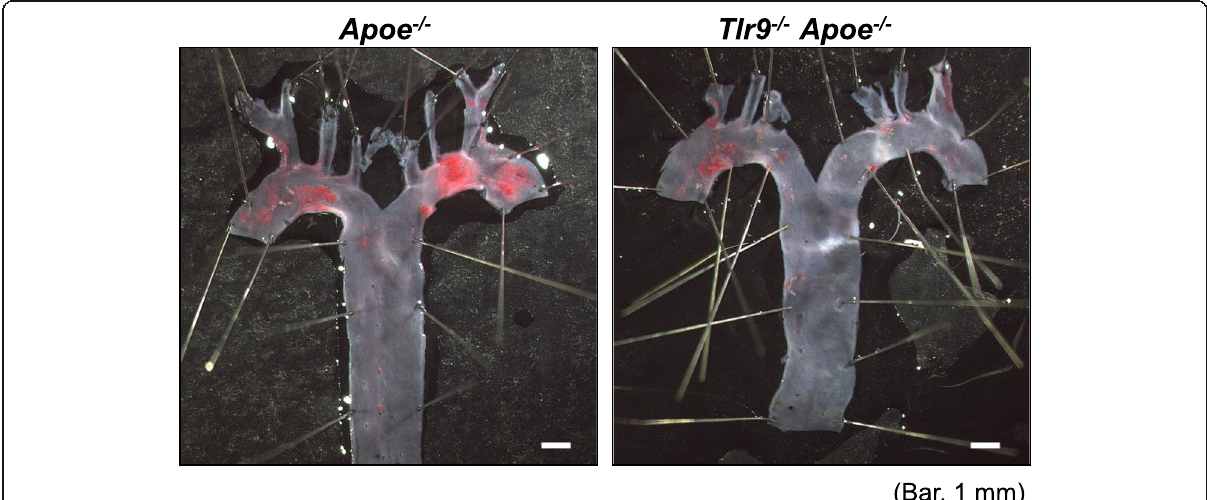
Fig. 4 Genetic deletion of TLR9 attenuated the development of atherosclerosis. Representative figures of Sudan IV staining of the aortic arch of Ang II-infused Apoe − / − or Tlr9 − / − Apoe − / − mice. Genetic deletion of TLR9 attenuated the development of atherosclerosis. Bar, 1